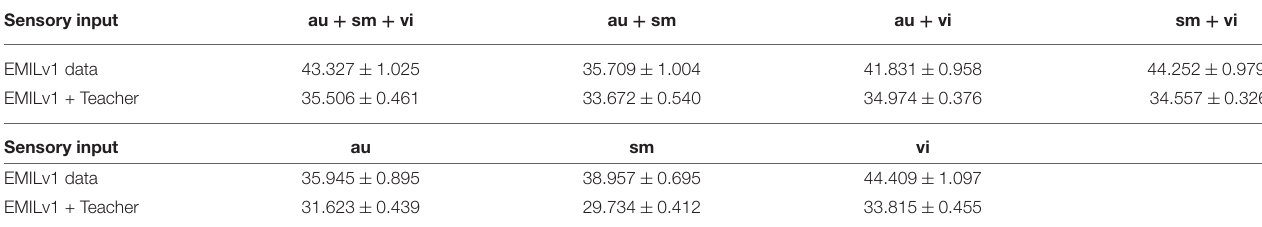
TABLE 2 | Test accuracy (%) for training on restricted sensory